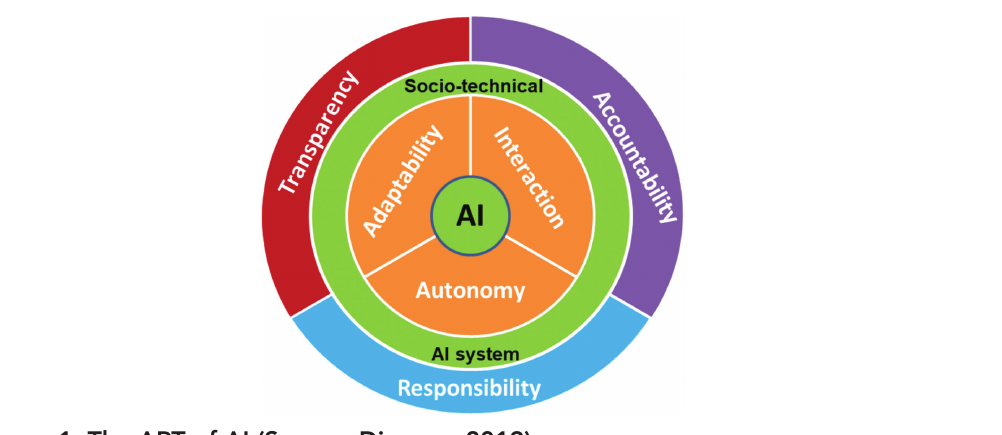
Figure 1: The ART of AI (Source: Dignum,